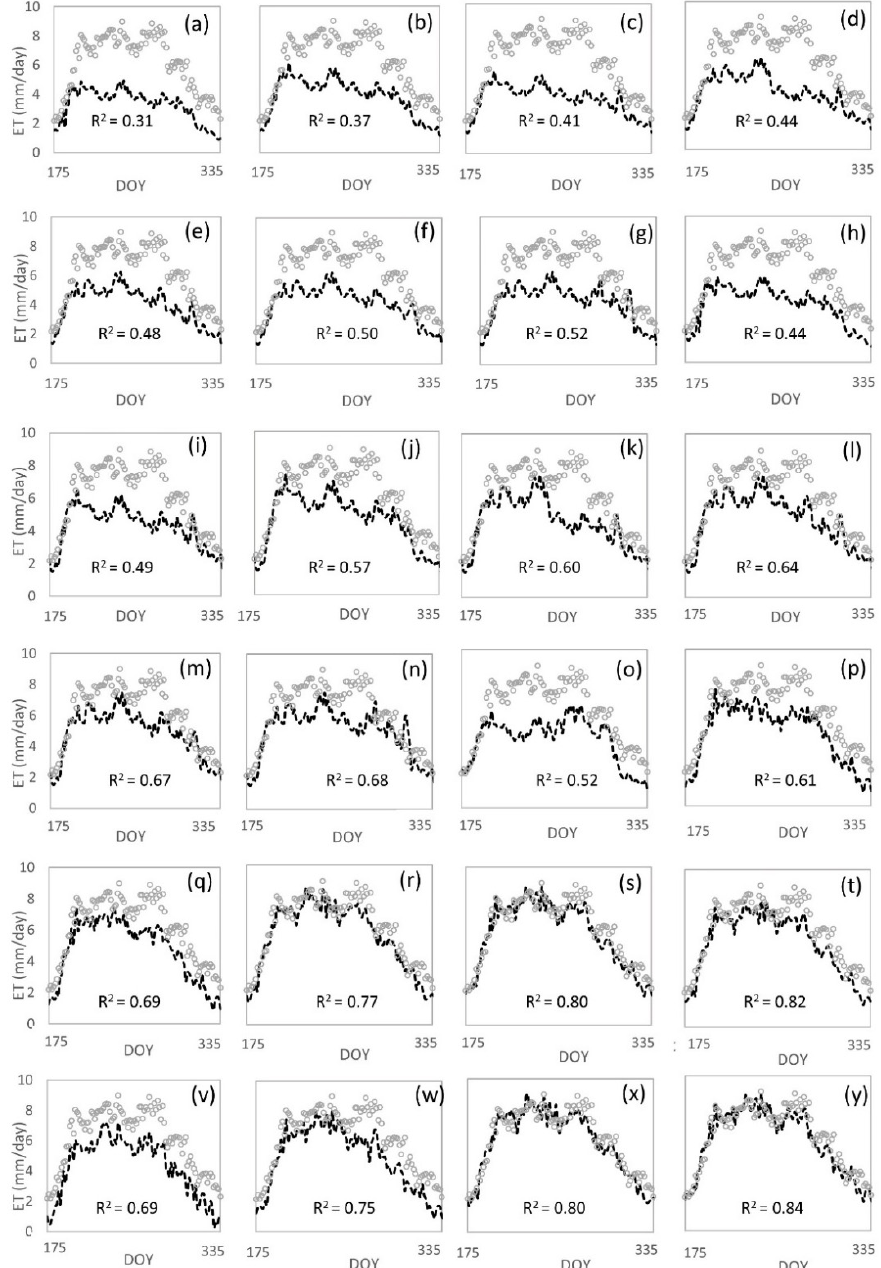
Figure 10. Time series of ET estimates using different data frequency updates. The letters ( a – y ) associated with each subfigure denote the experiments referenced in Table 4.